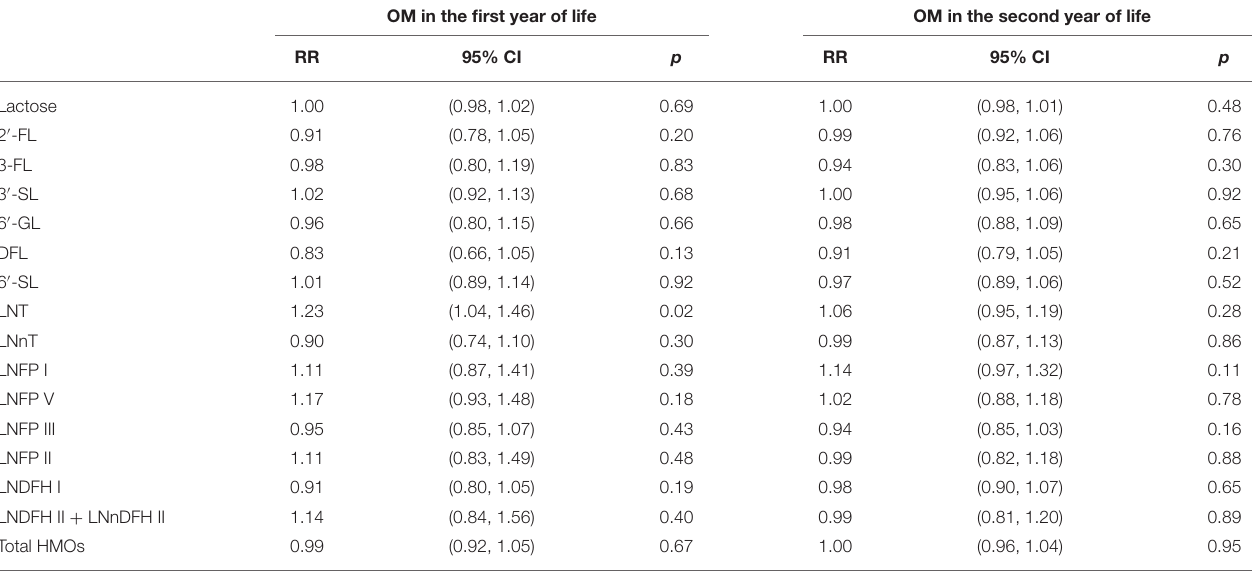
TABLE 7 | Adjusted associations between human milk oligosaccharides in group I milk measured at 6 weeks of lactation with otitis media in the first or second year of life in the Ulm SPATZ Health Study. OM in the first year of life OM in the second year of life RR 95% CI p RR 95% CI p Lactose